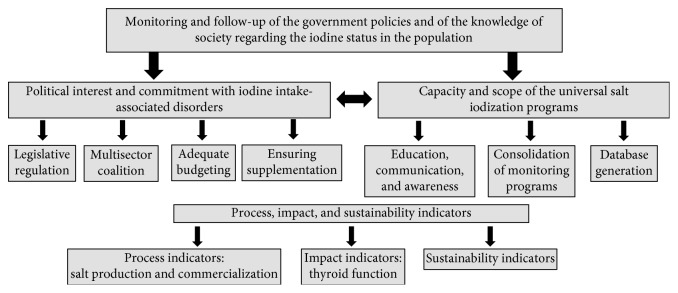
Summary of guidelines and decisions to consider regarding iodine intake programs.